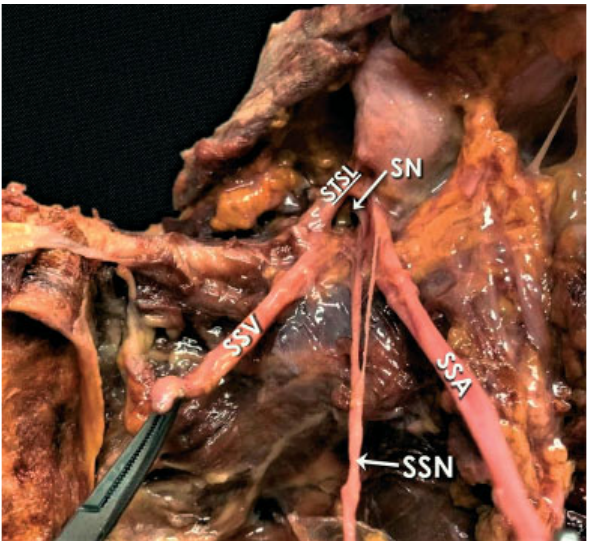
Fig. 4 Type-III content of the SN according to the classi fi cation used (nerve and both vessels through the notch). SSA, suprascapular artery; SN, suprascapular notch; SSN, suprascapular nerve; SSV, suprascapular vein; STSL, superior transverse scapular ligament.